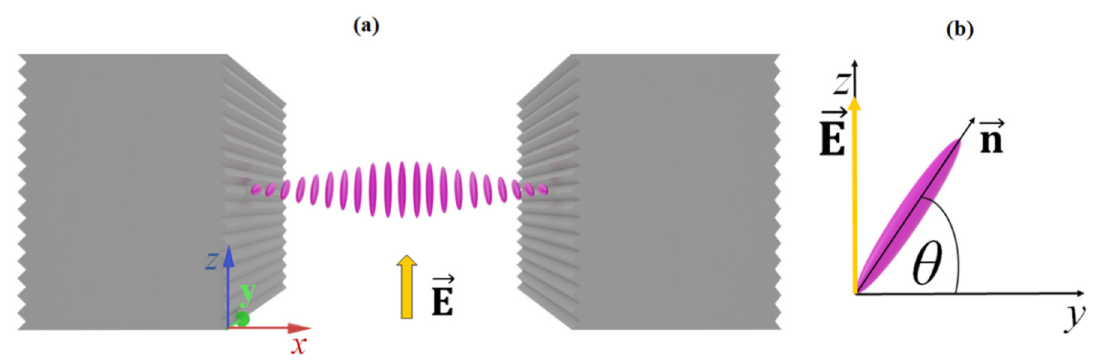
Figure 2. ( a ) Schematic drawing of the reorientation process of the LC molecules induced by an external electric field E oriented along the z -axis. ( b ) Local (re)orientation of the nematic director n under the influence of E , where θ ( x ) indicates inclination angle of n with respect to the y